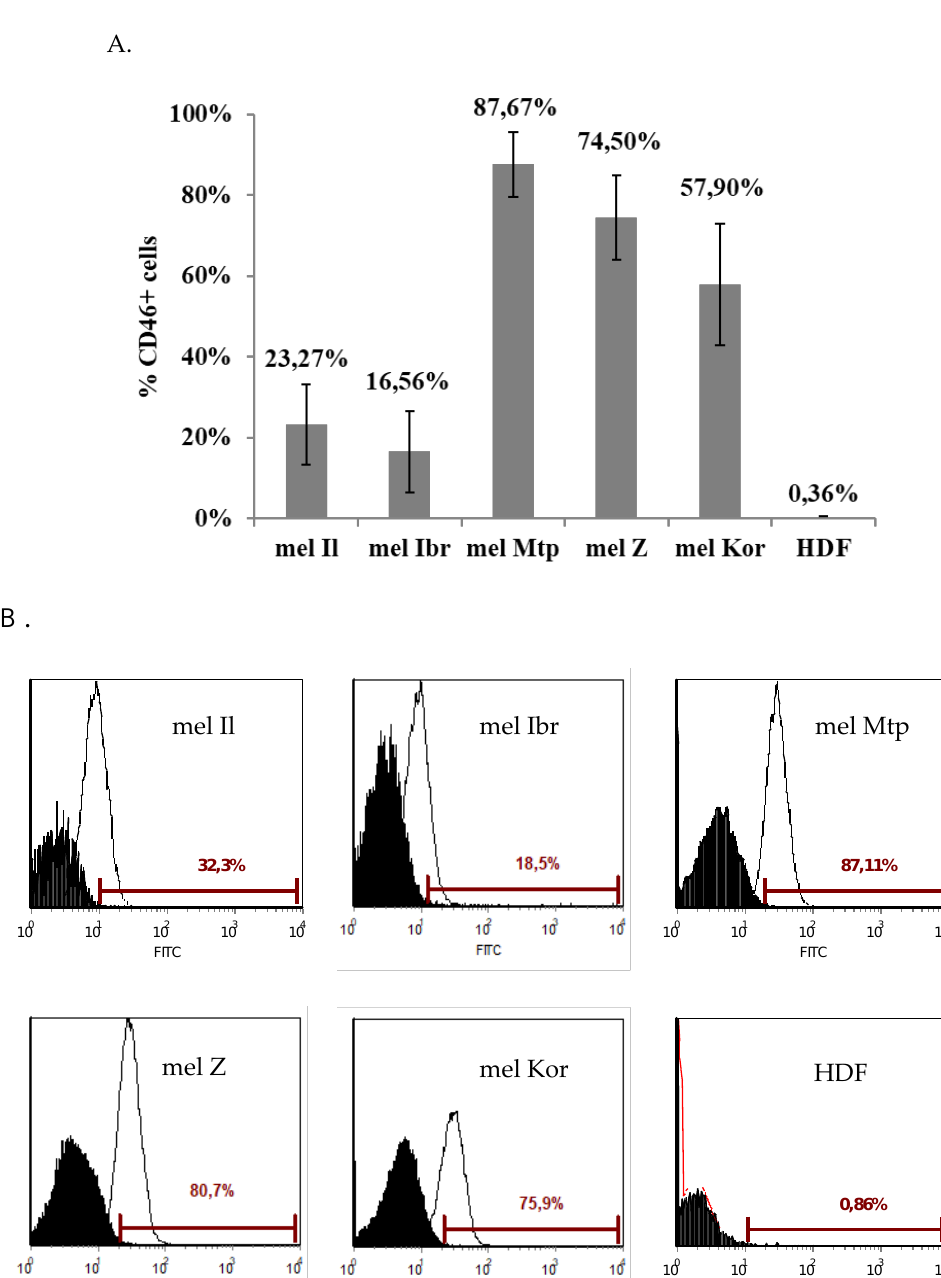
Figure 6. Expression of the CD46 receptor at the surface of melanoma cells and HDF as measured by flow cytometry. A total 1.0 × 10 5 cells were incubated with a FITC-conjugated anti-human CD46 antibodies in PBS containing 1.0% FBS for extracellular staining. After 30 min, cells were washed twice, resuspended in PBS and fixed with 1% PFA for 30 min. A . Plot of fluorescence intensity (relative to isotype) of cells stained with anti-CD46-FITC. The data shown are mean results from three separate experiments; error bars indicate standard deviation of the mean B . Representative histograms. The shaded histograms represent isotype control staining; the solid line histograms represent CD46 staining; OX—CD46 (FITC), OY—the number of cells.